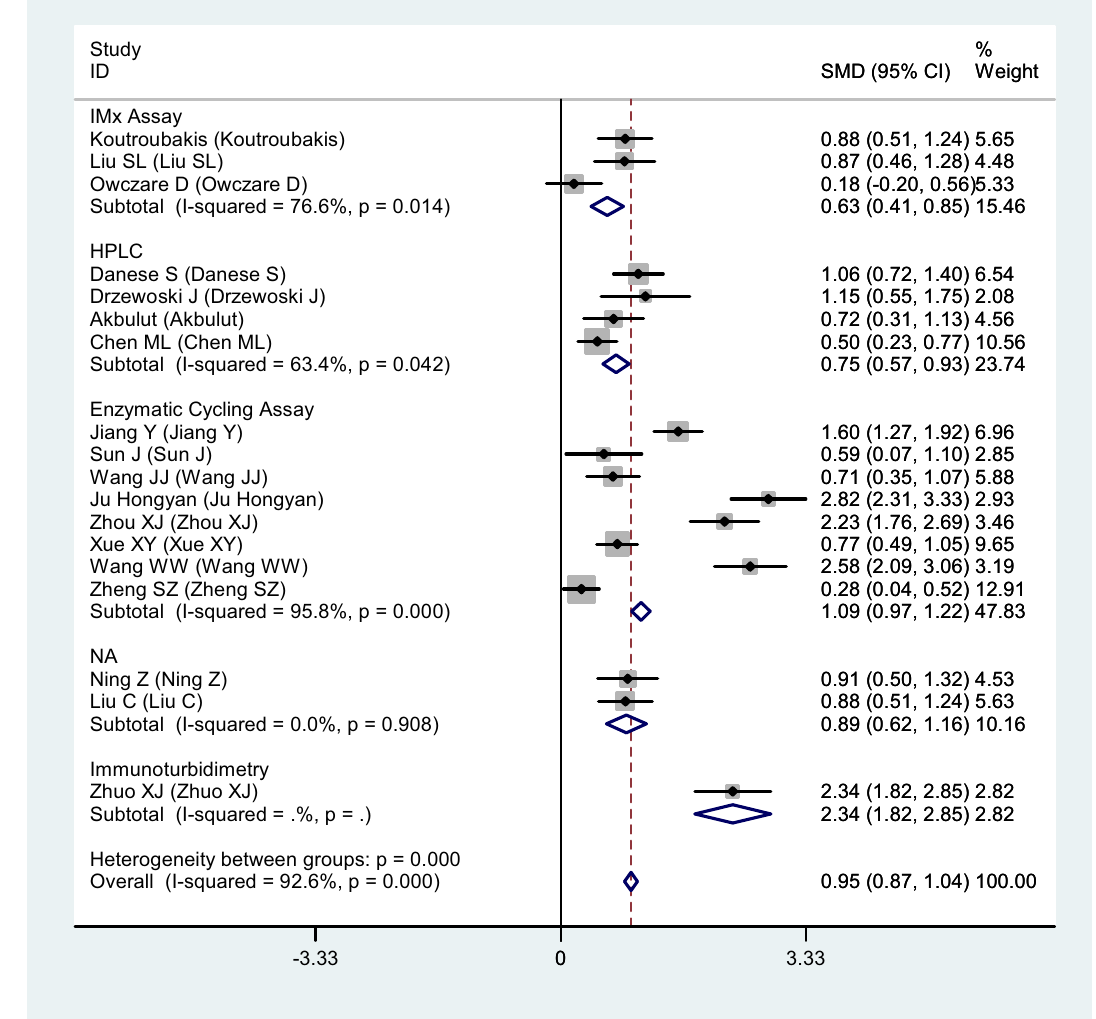
Figure 2: Forest plot of serum Hcy level and